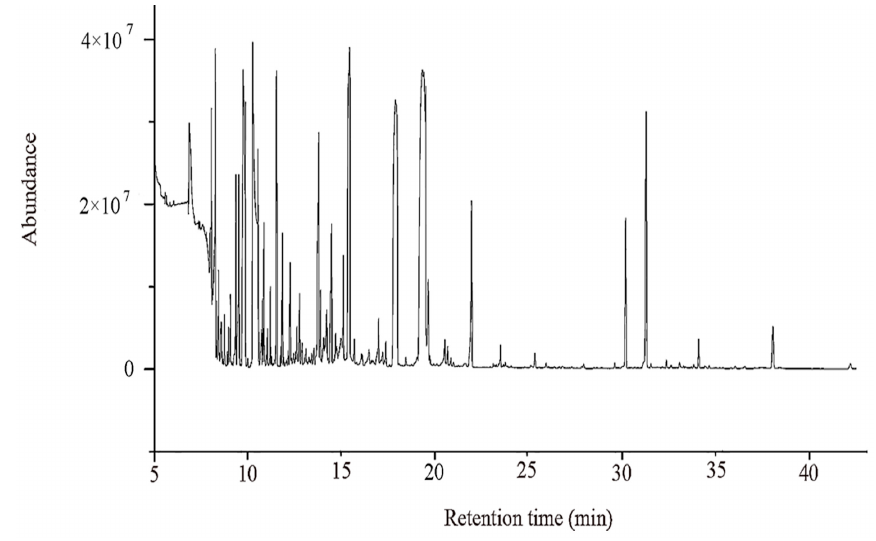
Figure 1. Overlays of total ion chromatograms (TICs) from GC-MS analysis of metabolites in pear fruit.